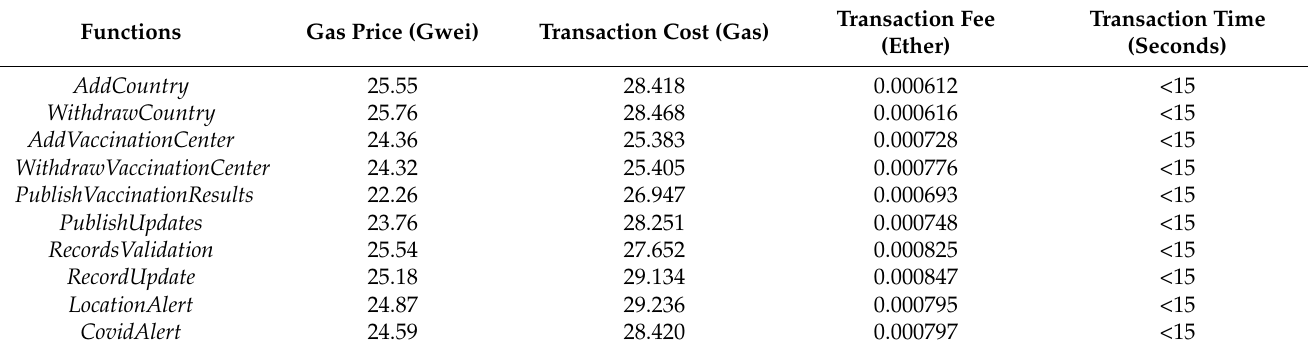
Table 1. Smart contracts cost and transaction analysis.